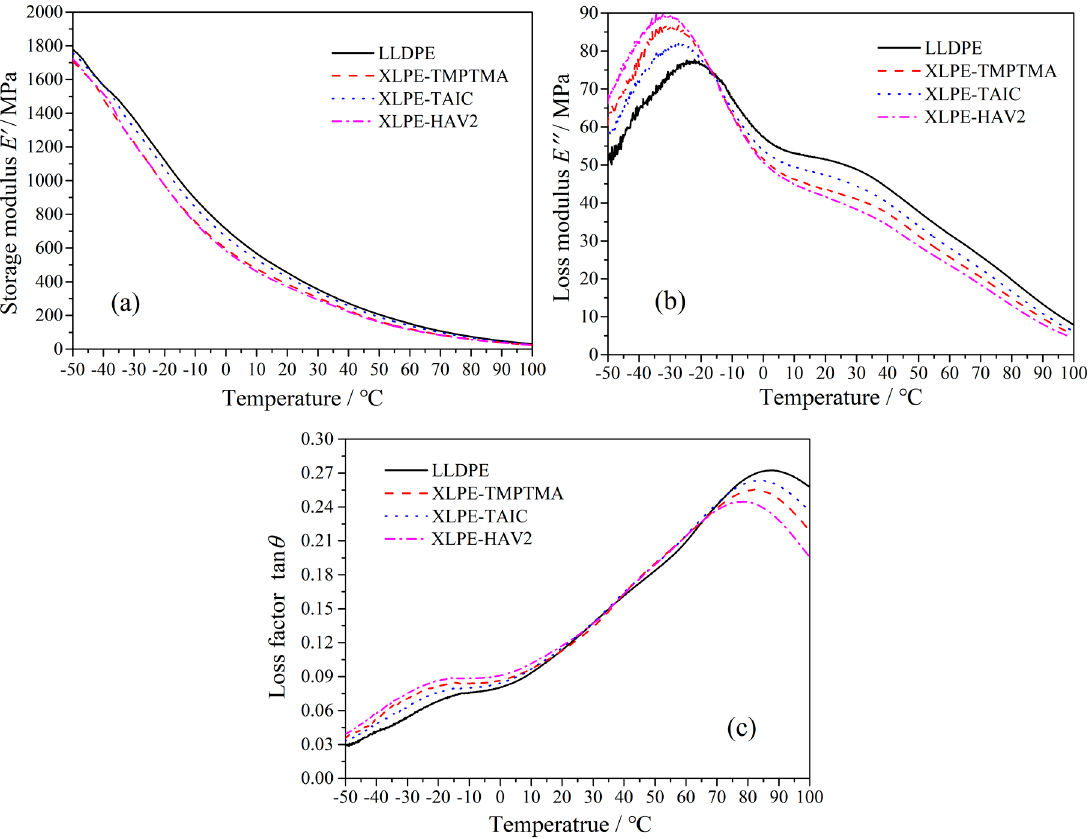
Figure 3. Dynamic thermomechanical analysis (DMA) temperature spectra of LLDPE and UV-XLPE: ( a ) storage modulus, ( b ) loss modulus, and ( c ) loss factor.